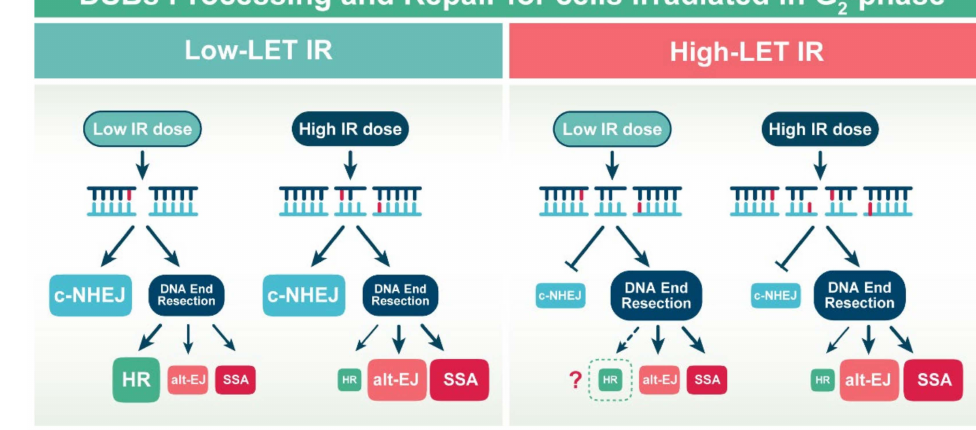
Figure 4. Exposure of cells to high-LET IR disrupts the balance between DSB repair pathways by shifting the processing to DNA end resection-dependent mechanisms (see text for